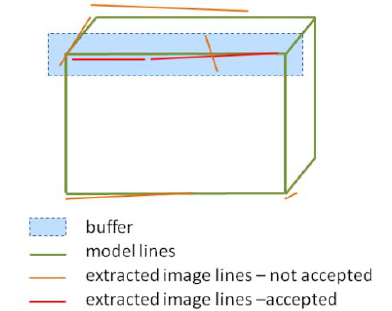
Figure 1. The principle of the correspondence